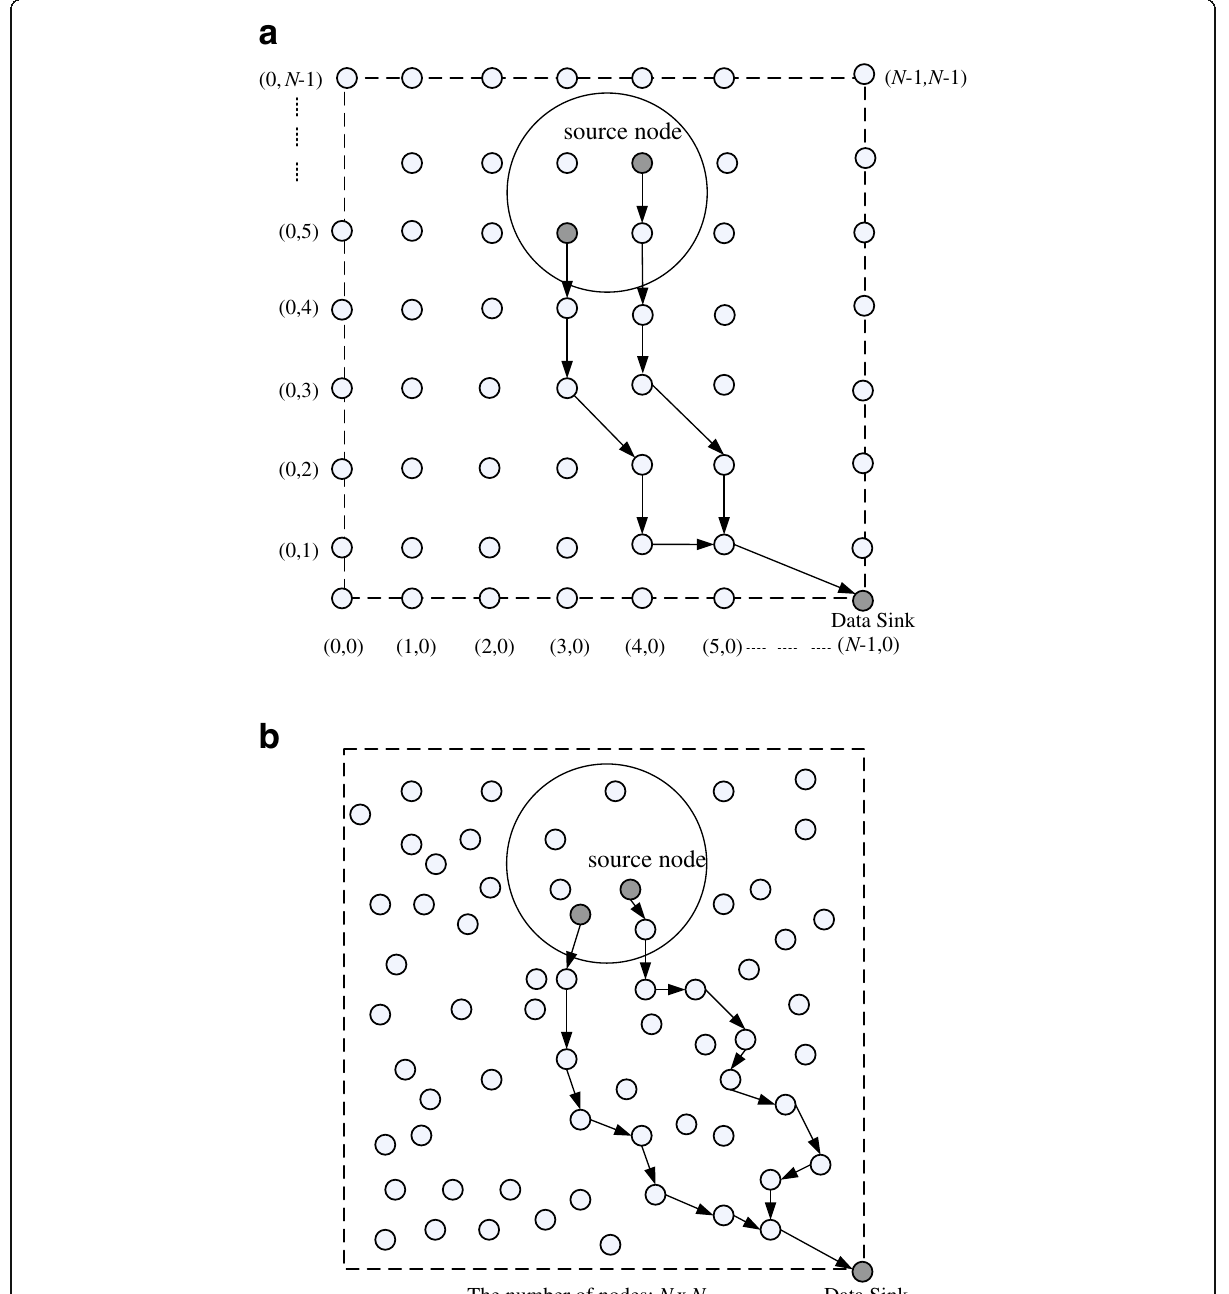
Fig. 8 Network simulation models with a deterministic and b random